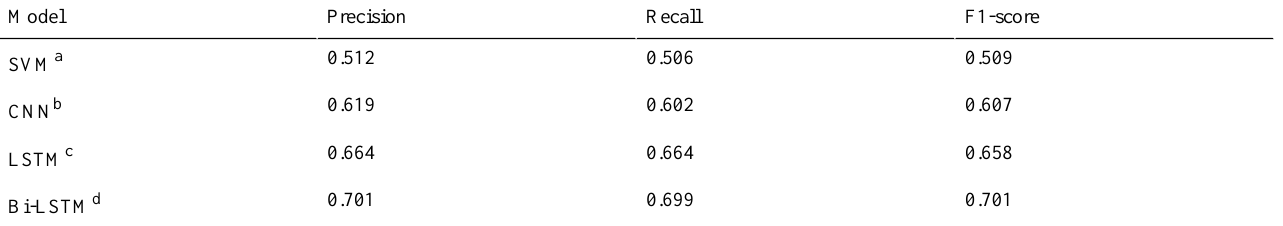
Table 2. The performance of the emotional polarity classification